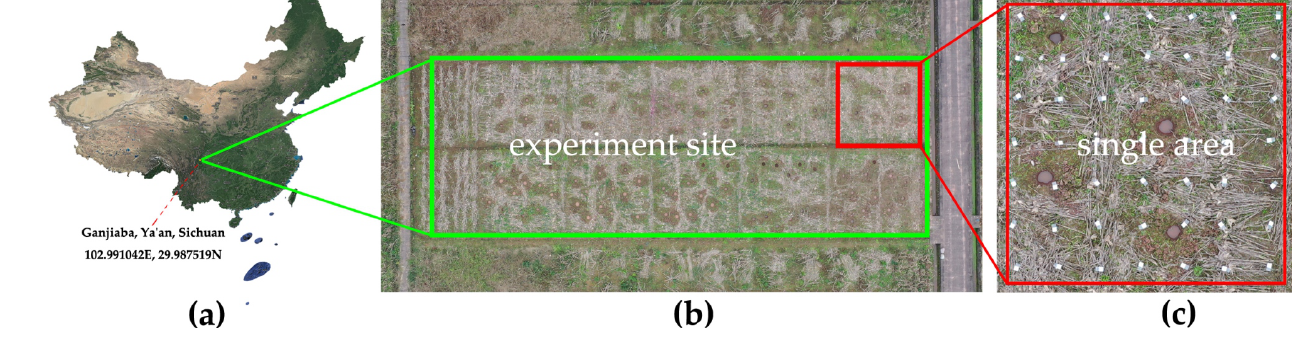
Figure 14. Overview of the experiment